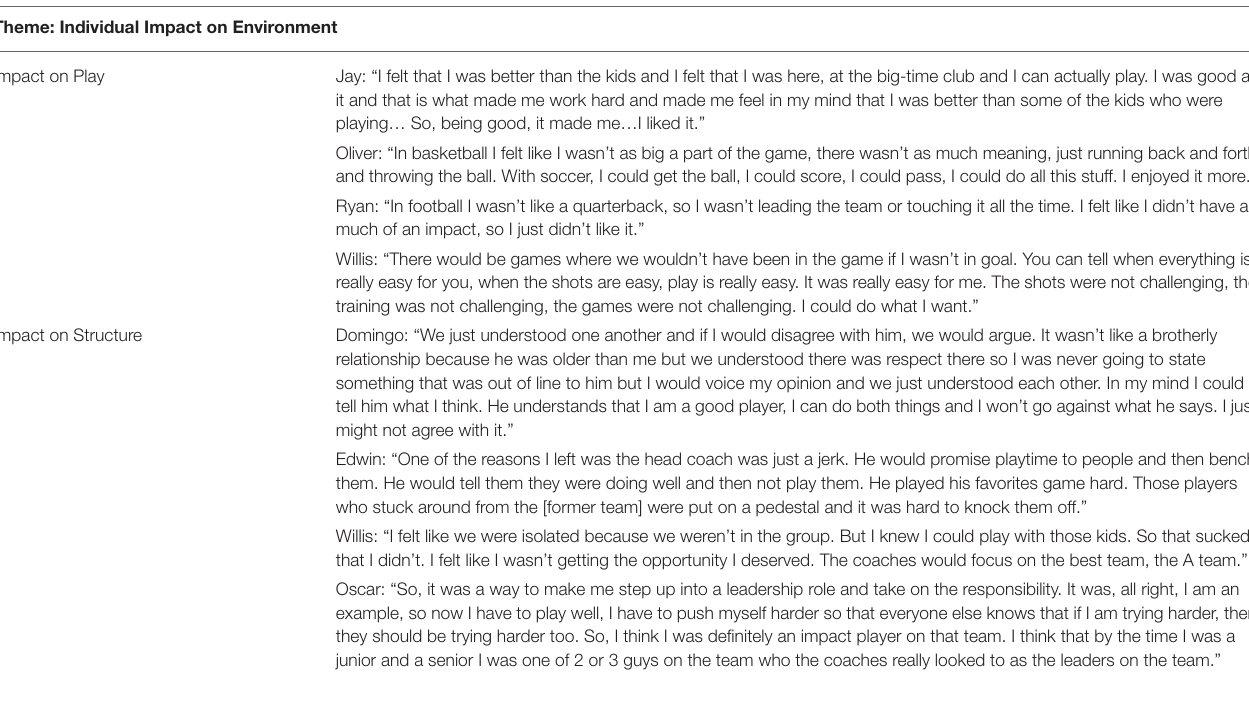
TABLE 1 | Exemplar data segments characterizing the patterns in the Individual Impact on Environment theme. Theme: Individual Impact on Environment Impact on